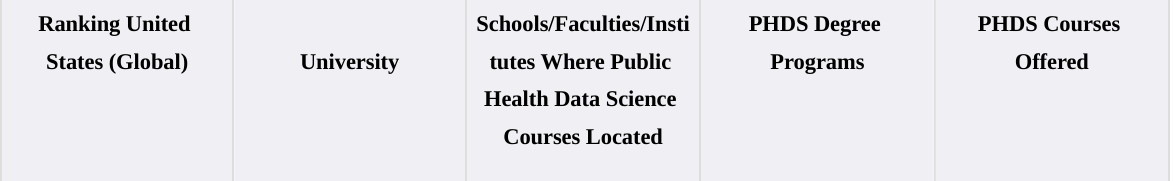
Table 1. Top 10 schools of public health in the United States and top 10 global universities for social science and public health as ranked by U.S. News & World